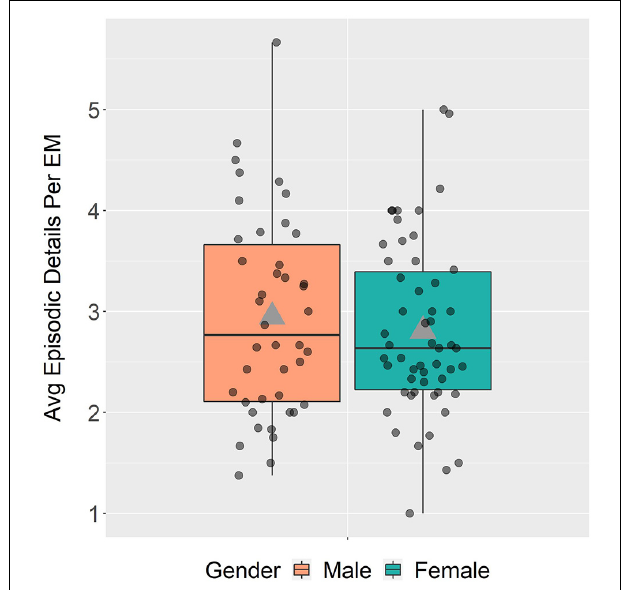
FIGURE 8 | Average (avg) episodic details per episodic memory (EM) in males and